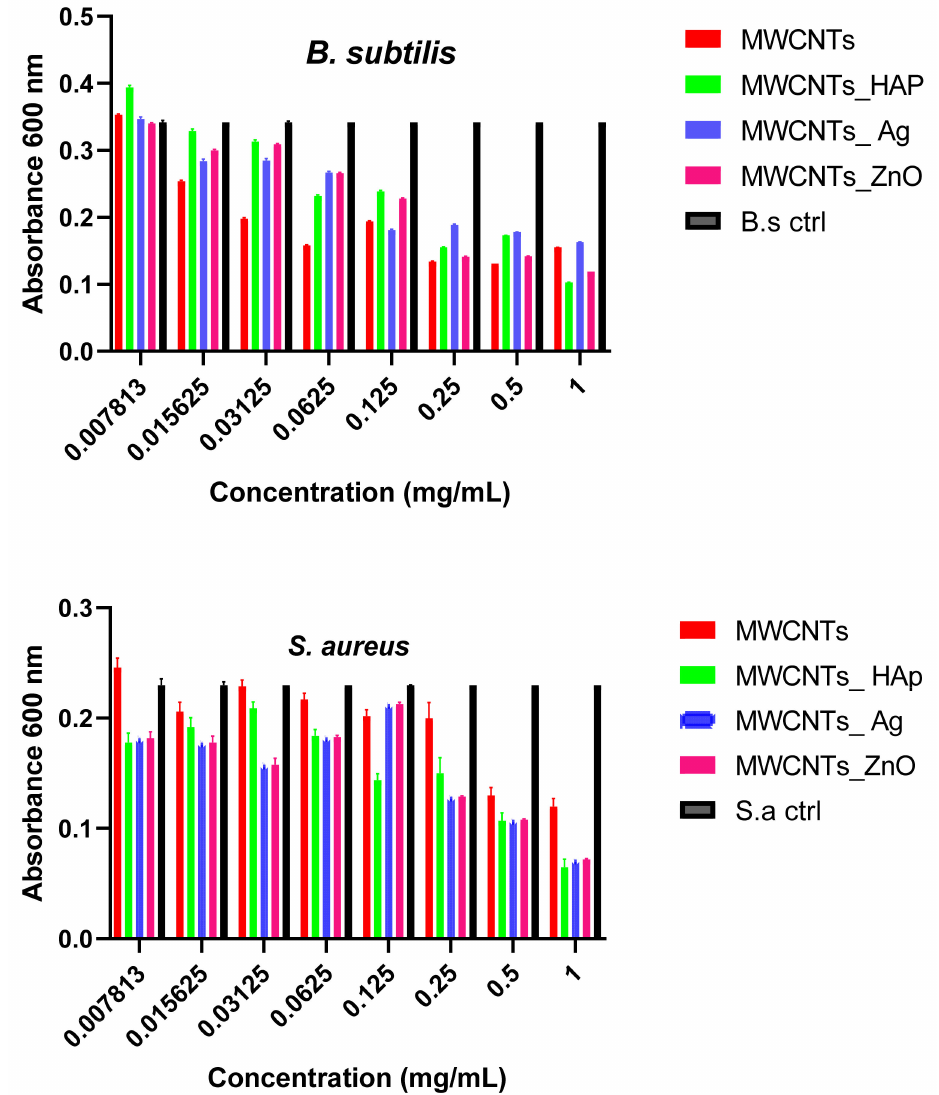
Figure 13. Graphical representation of the minimum concentration for eradication of biofilm for MWCNTs and decorated MWCNTs on Gram-positive strains. Data represented were mean of triplicate values with standard